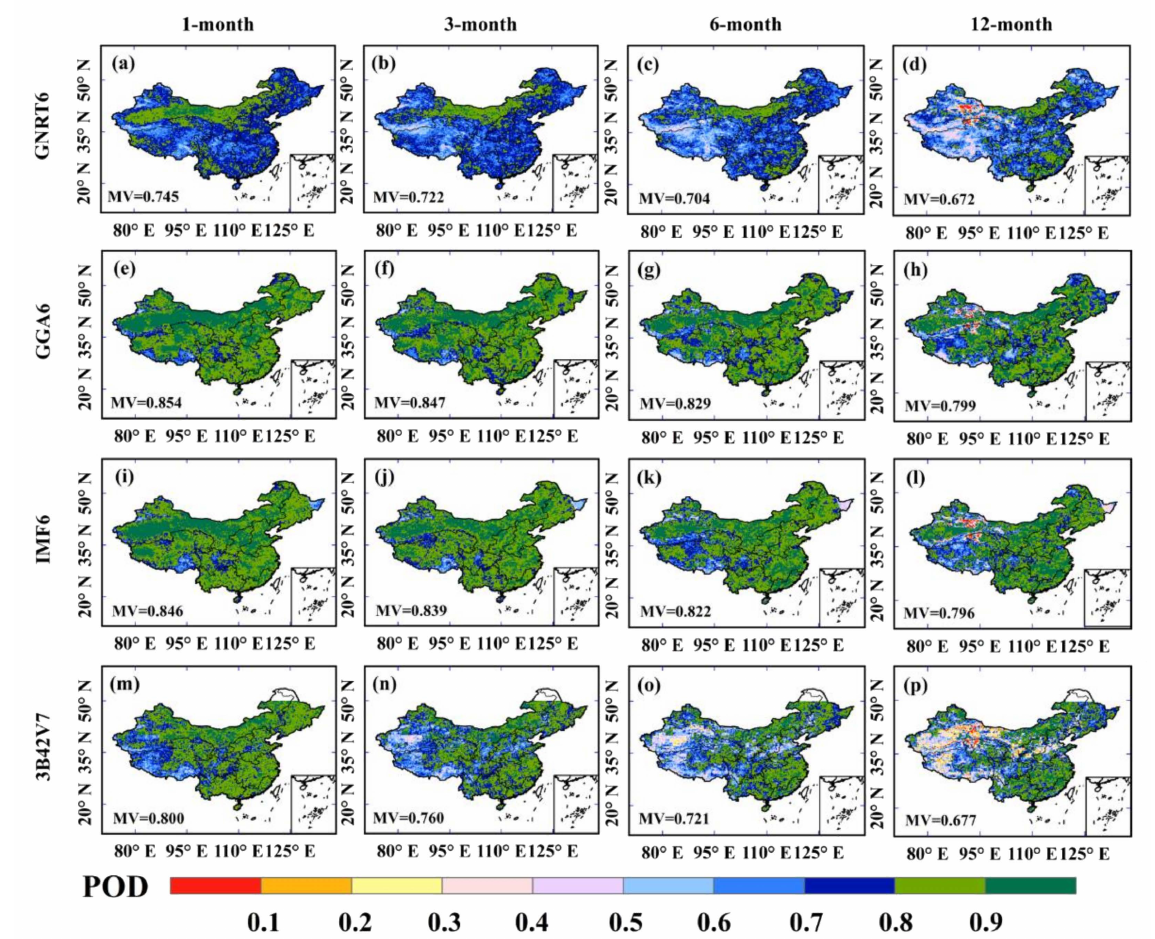
Figure 6. POD of the ( a , e , i , m ) 1-, ( b , f , j , n ) 3-, ( c , g , k , o ) 6- and ( d , h , l , p ) 12-month SPEI based on the four SREs w.r.t in situ observa-tions in June 2000–May 2019. Columns for different time scales, rows for different